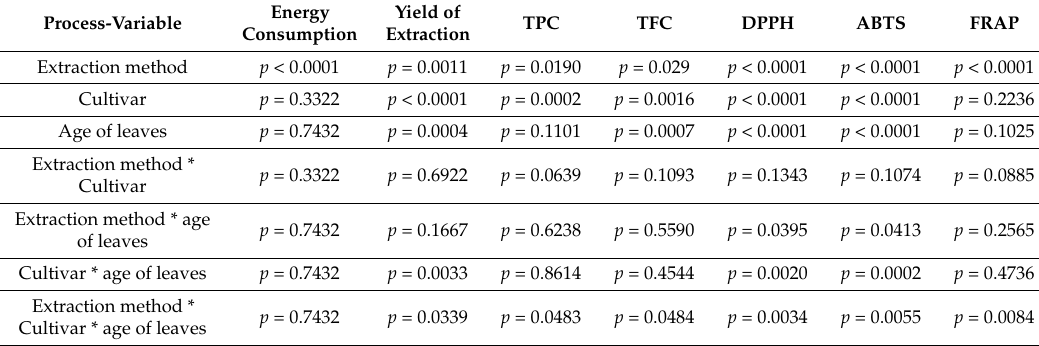
Table 3. ANOVA of results of energy consumption, yield of extraction, total phenolic content (TPC),